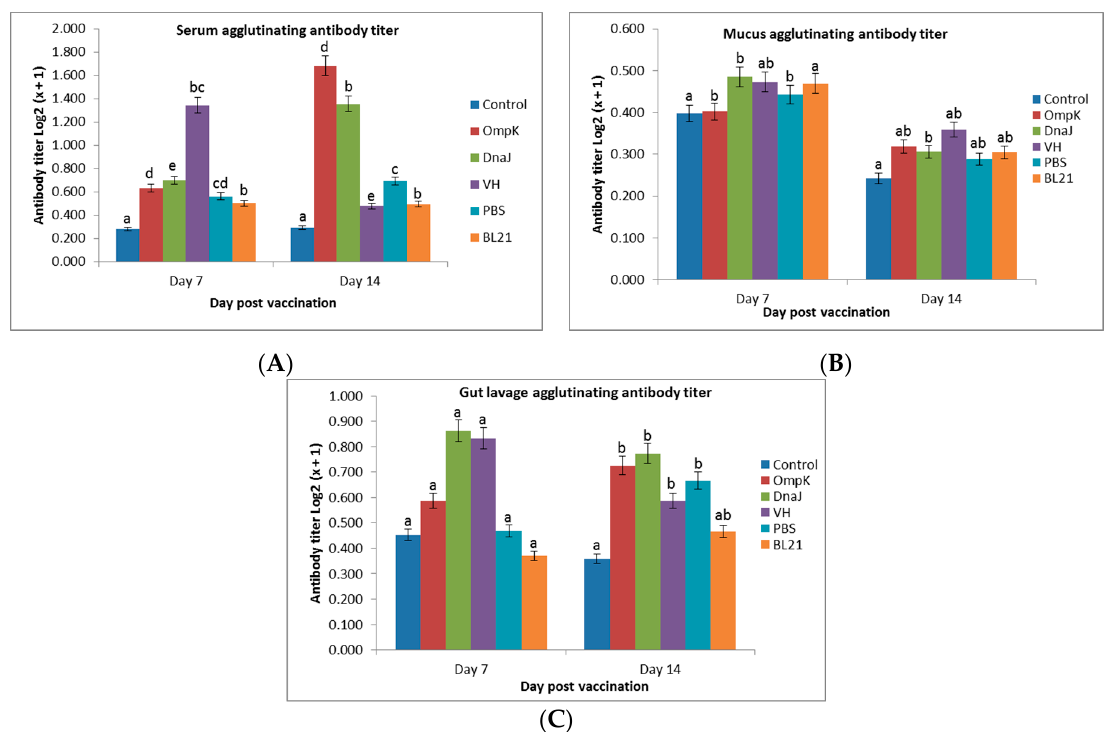
Figure 2. The agglutinating antibody titers in ( A ) serum, ( B ) mucus, and ( C ) gut lavage of immunized juvenile seabass at day 7 and 14 post-vaccination (mean ± sd). Significant differences are indicated by different letters ( p > 0.05).